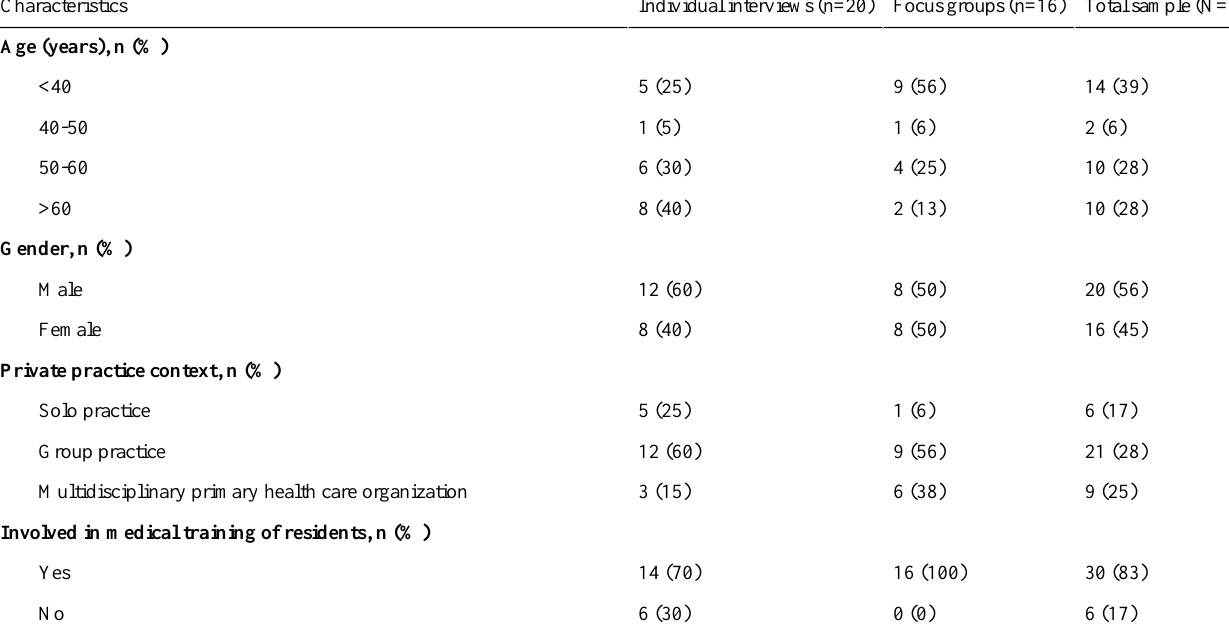
Table 1. General